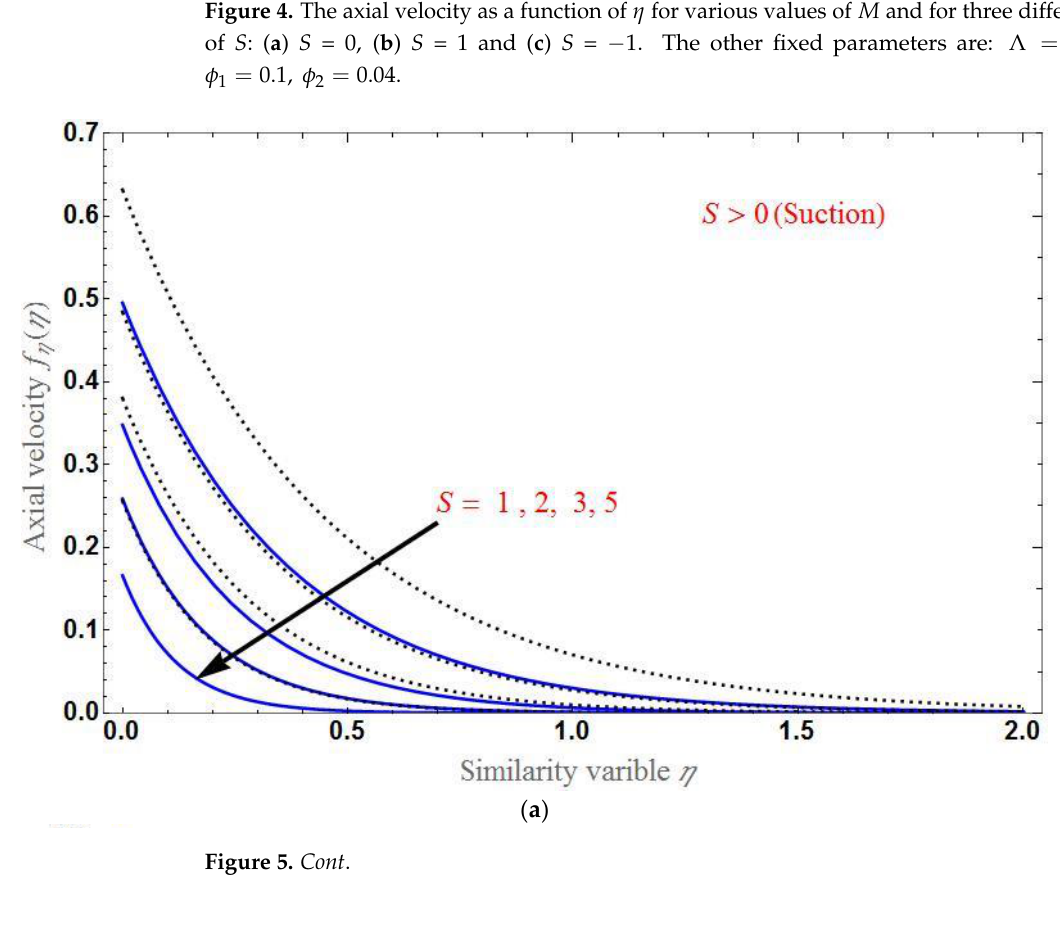
( b ) Figure 5. The axial velocity as a function of  for various values of S , ( a ) for suction case and (b) for injection case. The other fixed parameters are: